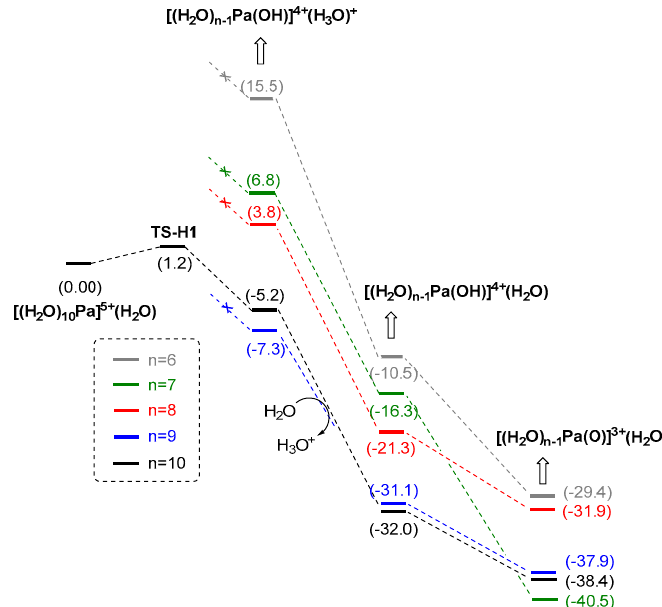
Figure 6. Comparison of Gibbs free energy profiles starting from [Pa(H 2 O) n ] 5+ (H 2 O) (n = 6–10) calculated with B3LYP-D3(BJ)/GEN/IEF-PCM//B3LYP/GEN /IEF-PCM method (for details see Table 2 caption).